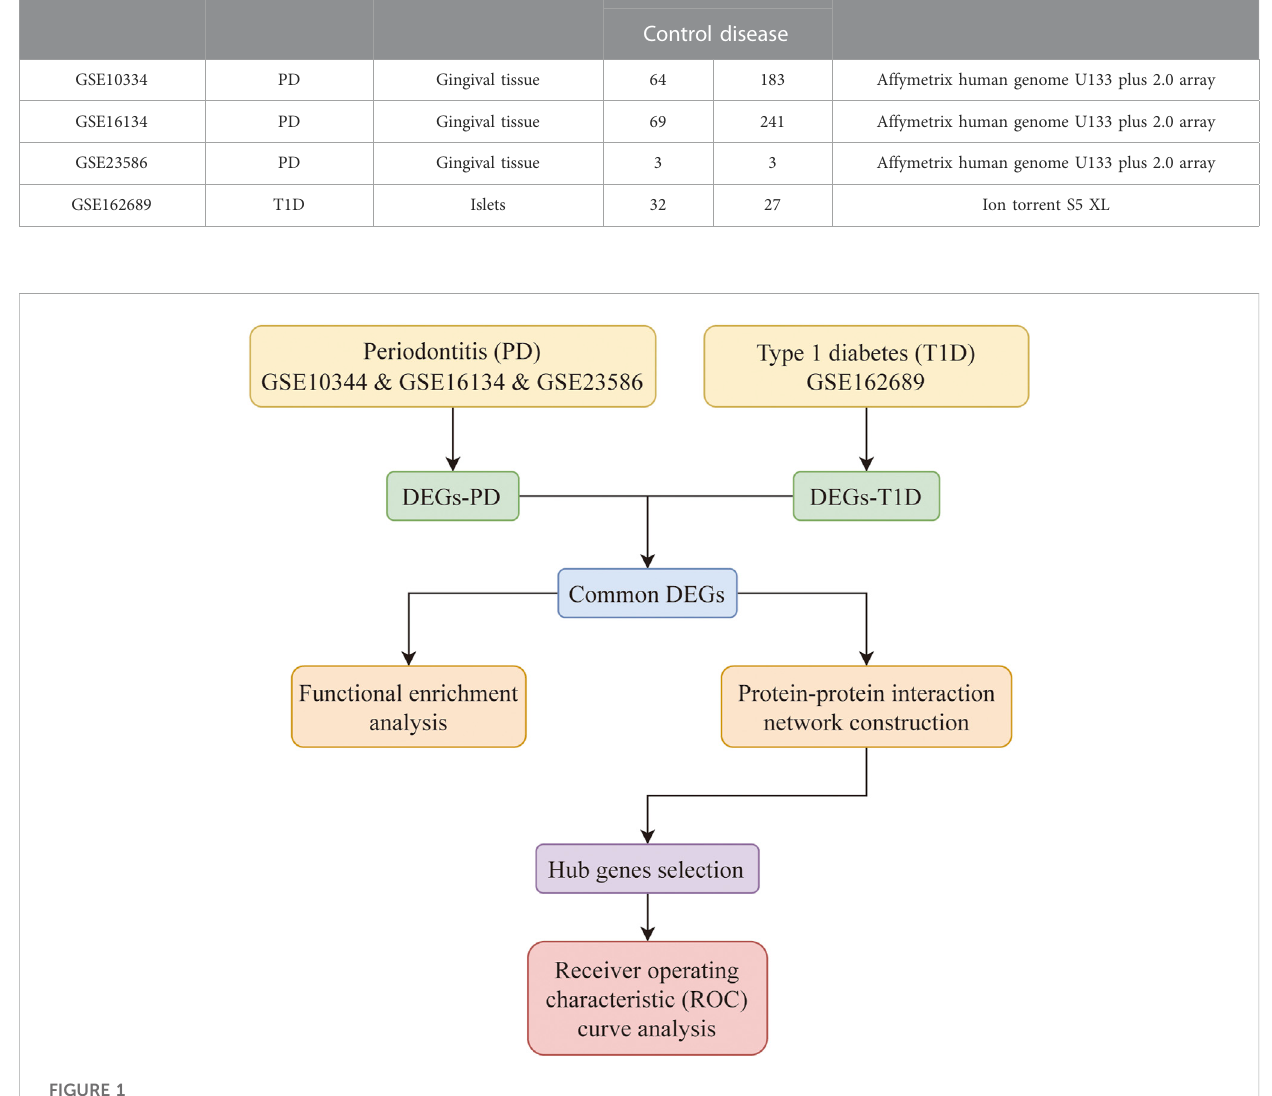
FIGURE 1 The work fl ow of this